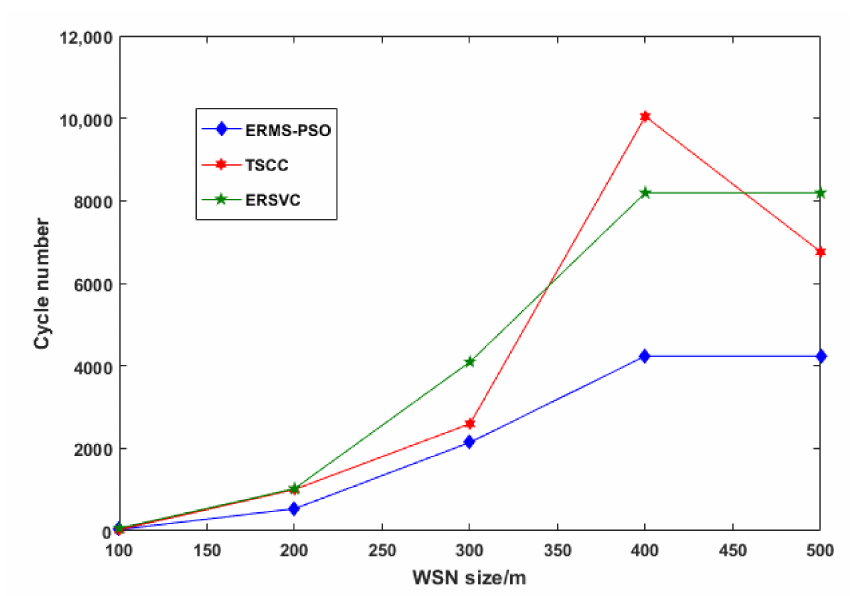
Figure 5. ERMS-PSO running